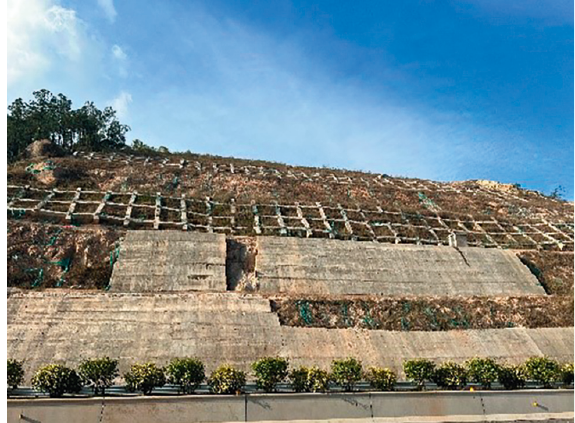
Figure 15: On-site completion